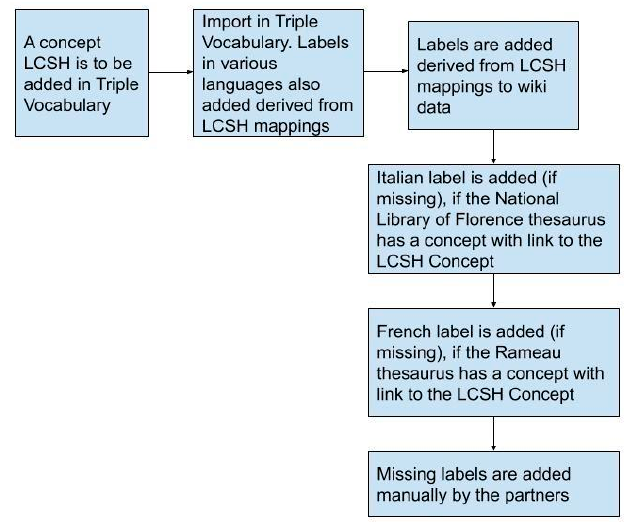
Figure 3. Schema of vocabulary enrichment.